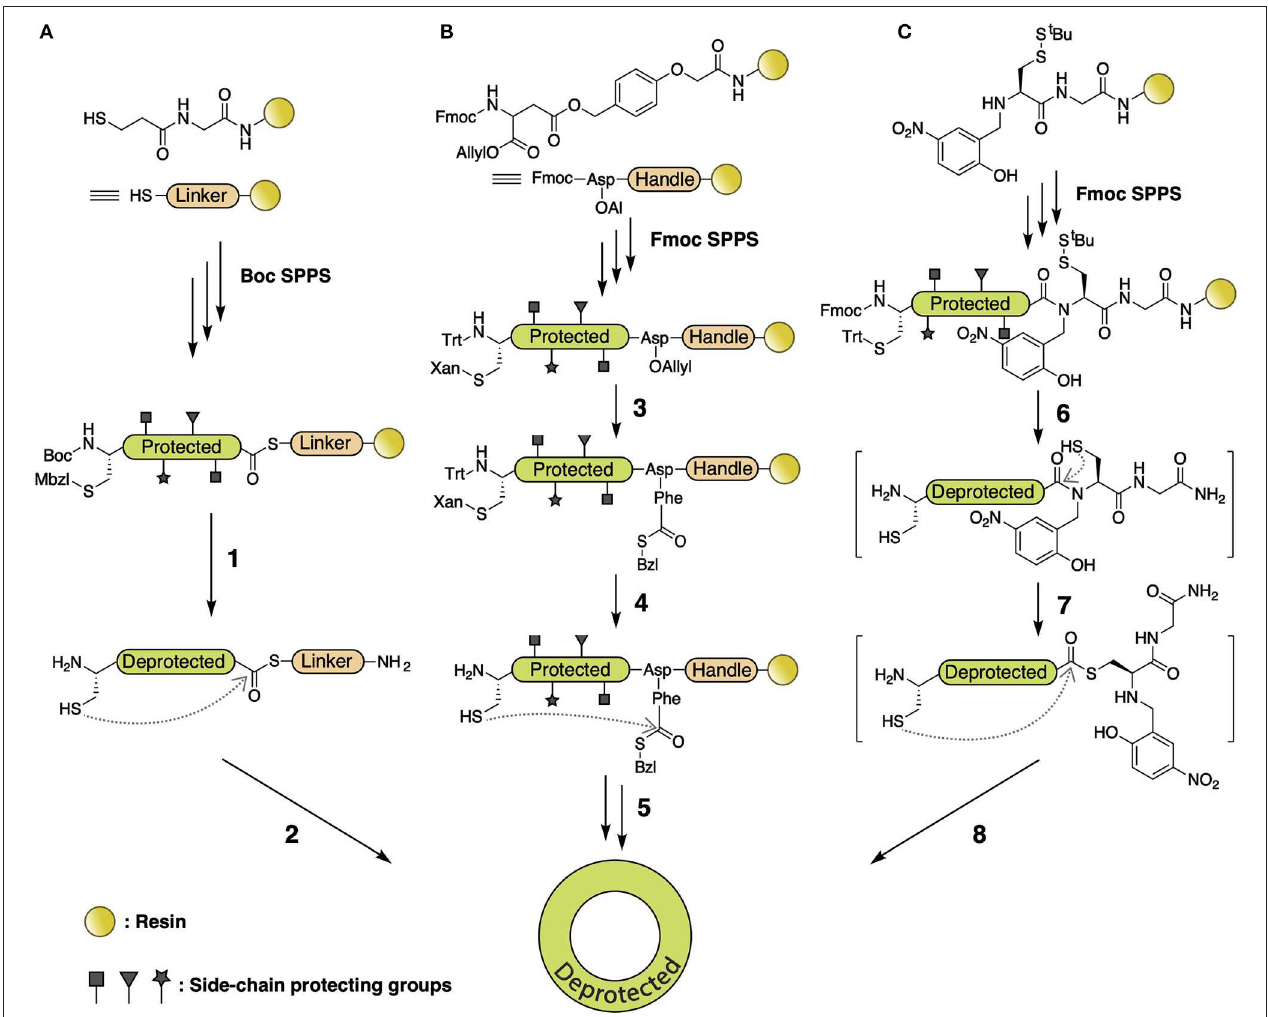
FIGURE 4 | (A) NCL of Kalata B1 using -SCH 2 CH 2 CO- as leaving group. A -SCH 2 CH 2 CO- linker is connected to PAM resin, followed by Boc SPPS to elongate the peptide. Cleavage and deprotection are performed with HF (1), and backbone autoligation is reached at pH 7.5 (2). (B) NCL of depsipeptide using -SBzl as leaving group. An α -carboxyl-protected Fmoc-Asp-OAllyl is attached to resin with side-chain carboxyl, followed by peptide elongation and deprotection of the allyl group by Pd(Ph 3 ) 4 , allowing coupling of Phe-SBzl with HATU/TIEA (3). N-terminal Cys and C-terminal Phe is deprotected with 1% TFA (4) and cyclized with 6M Gdn.Cl at pH 7.5, followed by deprotection with 90% TFA (5). (C) NCL of cDRPs using N-Hnb-Cys crypto-thioester as leaving group. An N-Hnb-Cys is assembled on resin before peptide assembly by Fmoc SPPS, followed by side-chain deprotection with 95% TFA (6). S- t Bu is deprotected with 50mM tris(2-carboxyethyl)phosphine (TCEP) and N-to-S acyl transfer (7) followed by intramolecular NCL induced in 100mM 4-mercaptophenylacetic acid (MPAA) at 37 ◦ C under argon atmosphere